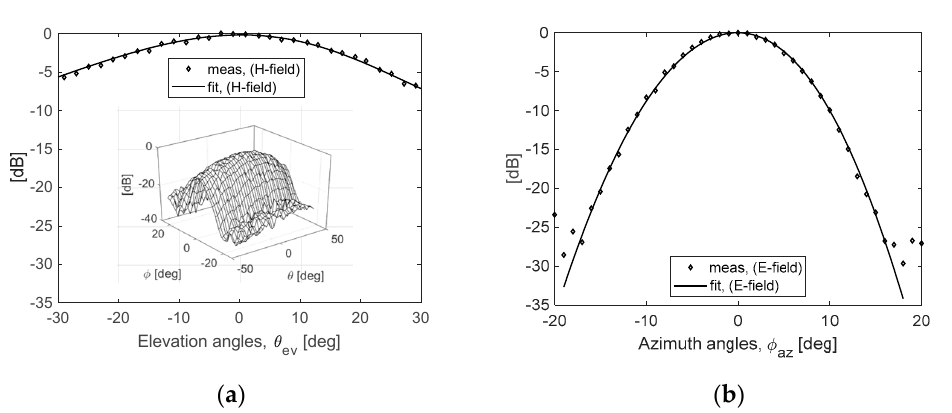
Figure 6. Measured Tx / Rx antenna beam pattern for the airborne FMCW SAR system: ( a ) shows the elevation cut (half-power beamwidth 37.9 ◦ ) and 3D pattern, and ( b ) is the azimuth cut (half-power beamwidth 11.4 ◦